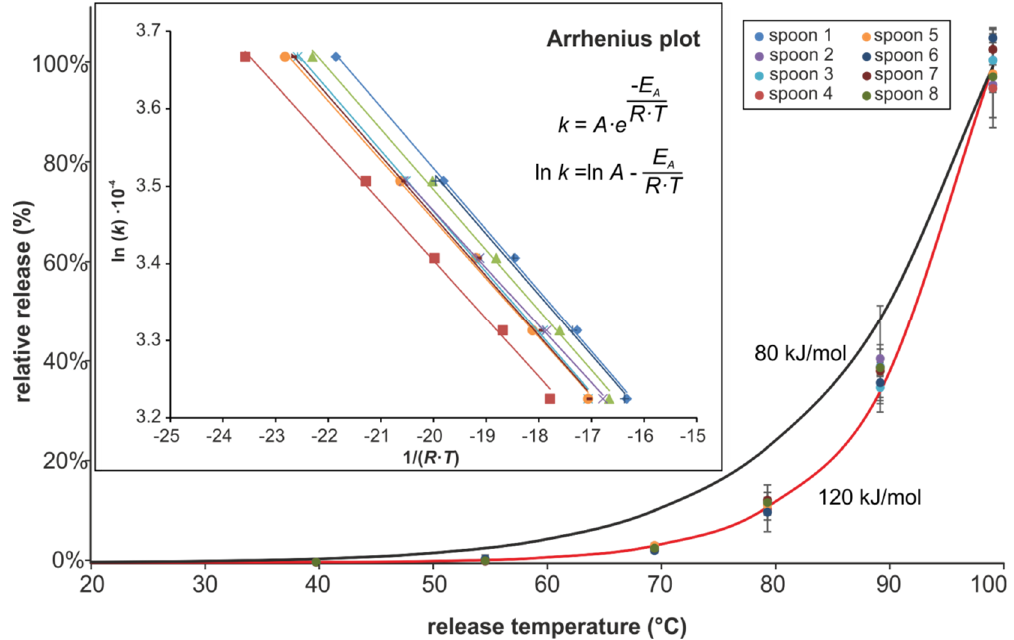
Figure 5. Temperature dependence of melamine release (red line: calculated values for an activation energy of 120 kJ/mol, black line: calculated values for an activation energy of 80 kJ/mol); error bars indicate the range of the averaged duplicates. Inset: Arrhenius plots.